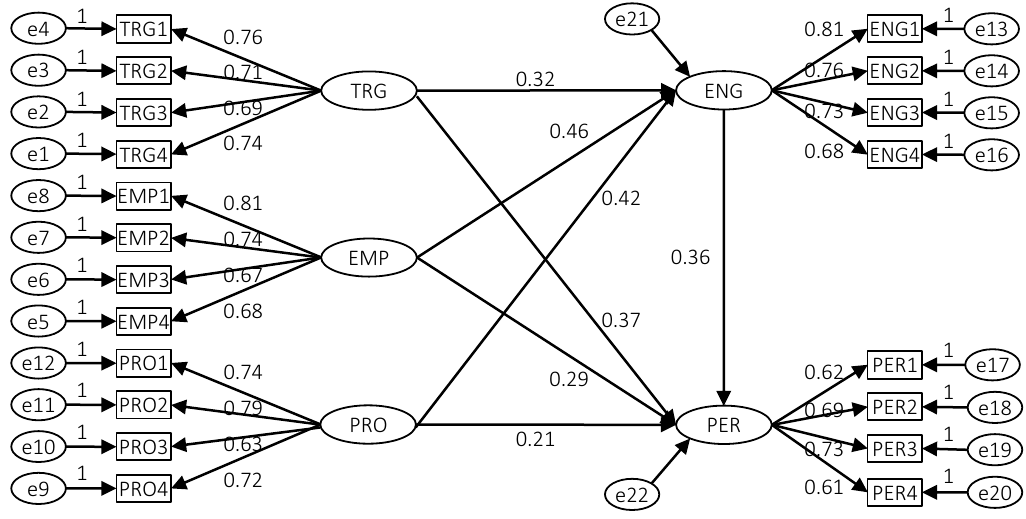
Figure 3. Structural research model